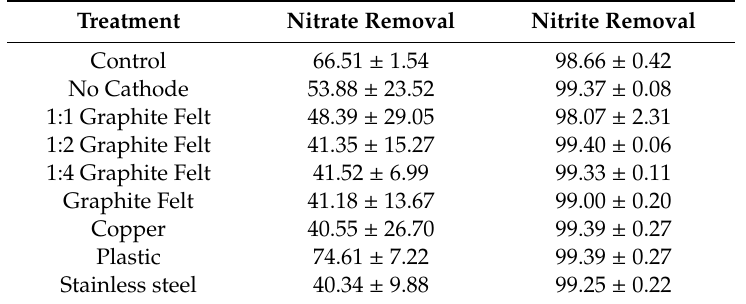
Table 1. Average ( n = 3) and standard deviation of nitrate and nitrite removal e ffi ciency